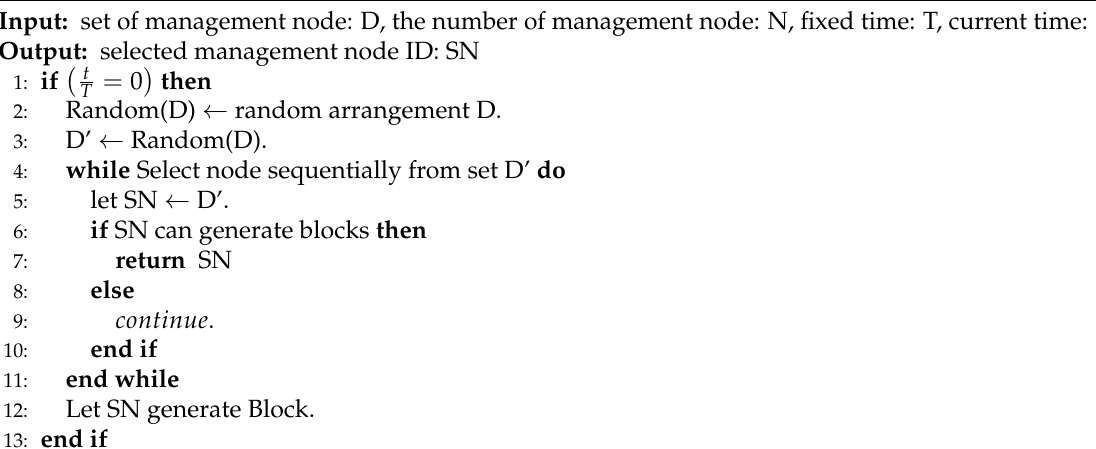
Algorithm 2 Algorithm for